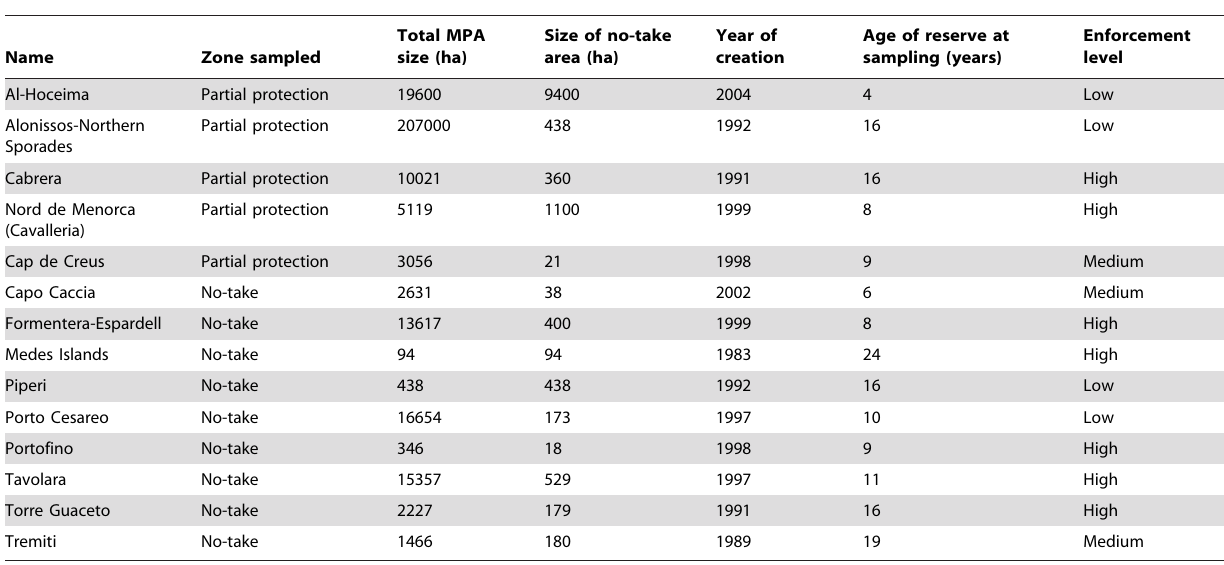
Table 1. Characteristics of the marine protected areas investigated in this